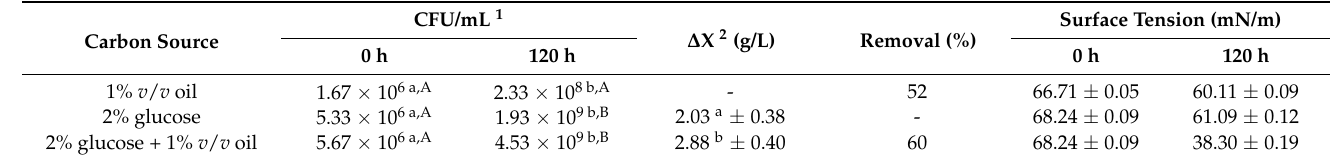
Figure 1. Cell growth profiles of Y. lipolytica IMUFRJ 50682 in seawater with 1% v / v oil (open circles), seawater with 2% glucose (black squares), and seawater with 2% glucose and 1% v / v oil (grey diamonds). Table 1. Colony forming units (CFUs), variation of the cell concentration ( ∆ X), oil removal (measured in a spectrophotometer at 240 nm), and the surface tension during the oil biodegradation by Y. lipolytica in seawater with carbon sources.